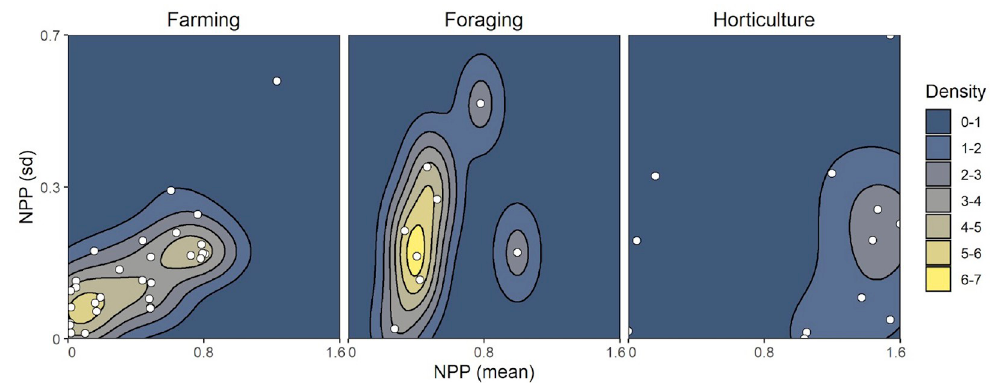
Fig 3. A density plot for the observations (points) in our dataset. Color represents the density of observations (societies) along both environmental dimensions (mean NPP and standard deviation in NPP).